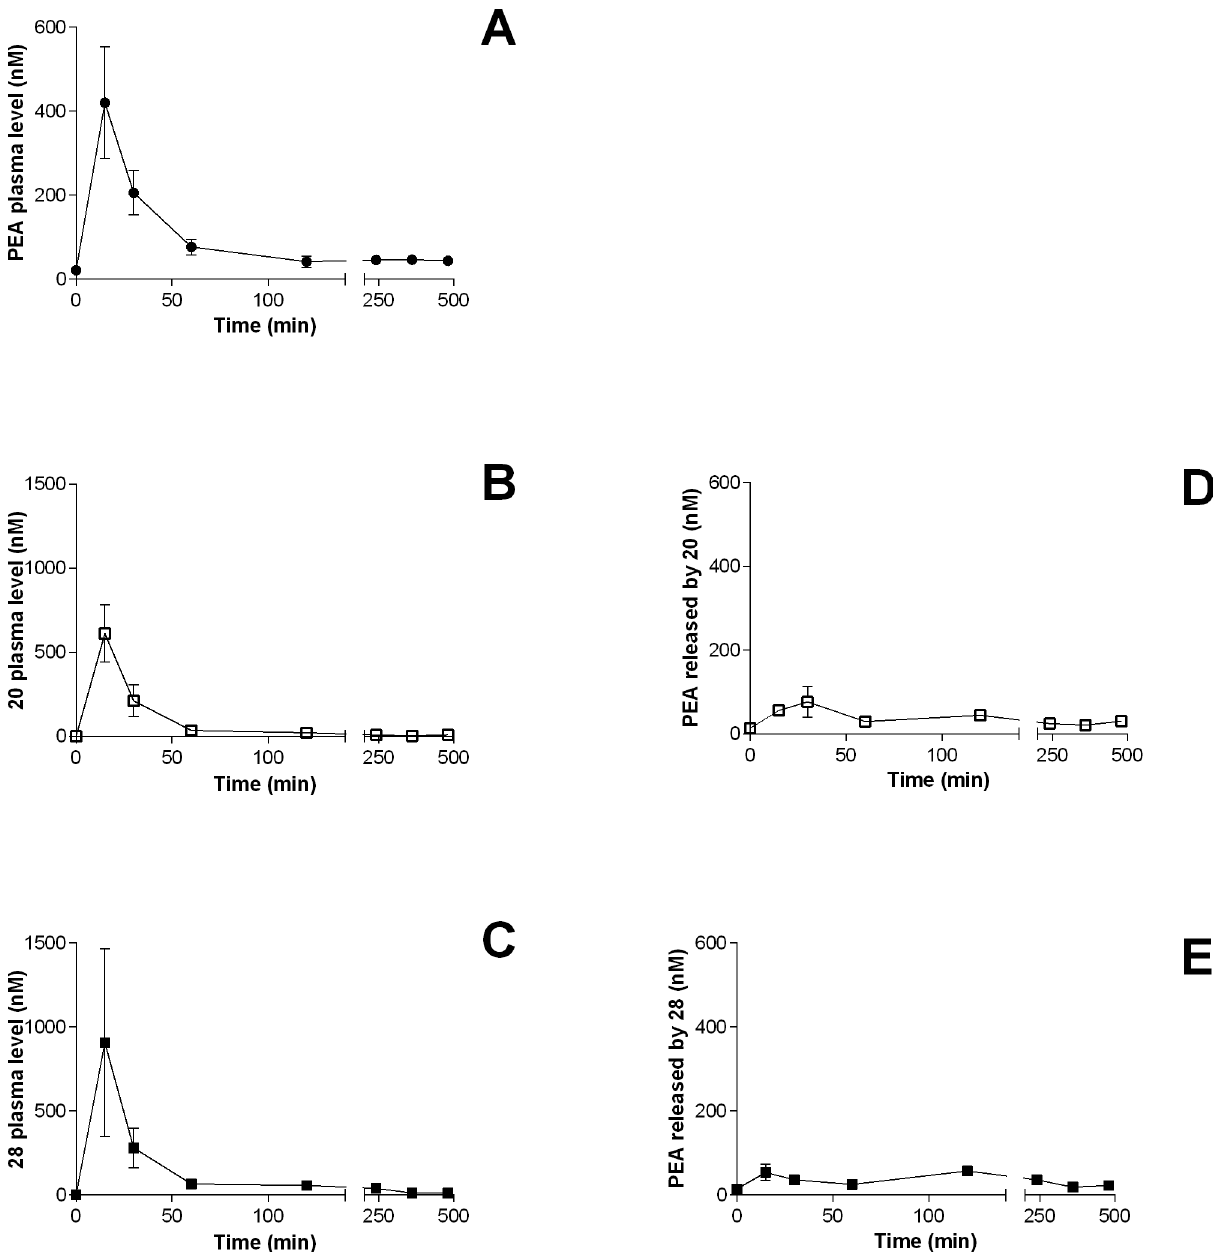
Fig 10. Prodrug and PEA plasma levels after oral administration to rats. a-c) Plasma levels of PEA ( ● ), 20 ( □ ) and 28 ( ■ ) after a single oral administration to male Wistar rats of equimolar doses (PEA: 100 mg kg -1 ; 20 and 28 : 145 mg kg -1 ). d-e.) Plasma levels of released PEA after a single oral administration of 20 ( □ ) and 28 ( ■ ). Data are expressed as means ± SEM, n =